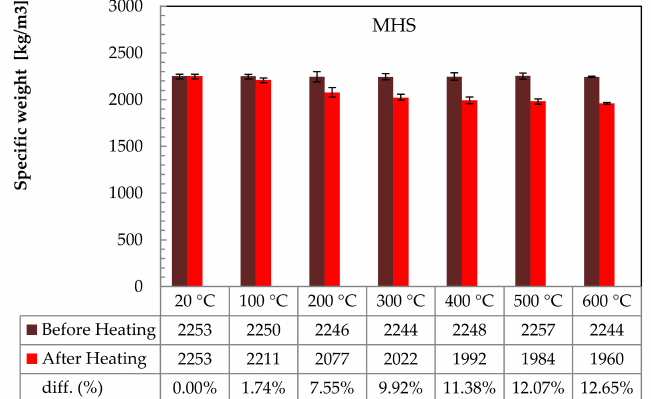
Figure 5. Weight loss due to thermal treatments for the high strength mortar